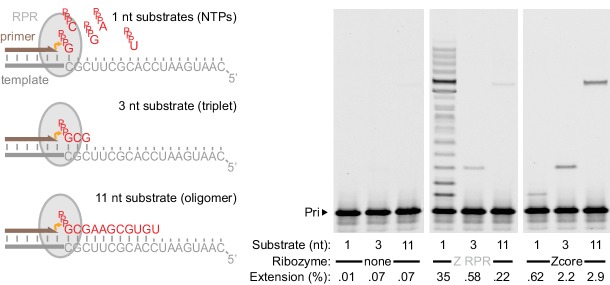
Templated ligase activity from a mononucleotide polymerase.Extension of primer A11 on template HTI by the Z RPR (Wochner et al., 2011) and a 3’ truncation of it (Zcore, Figure 1a) at −7˚C in ice for 8 days (0.5 μM of each RNA), adding as substrates either a long oligonucleotide (‘11 nt’, pppGCGAAGCGUGU at 0.5 μM), a triplet (‘3 nt’, pppGCG at 5 μM), or NTPs (‘1 nt’, at 1 mM each). Gel densitometry was used to calculate the percentage of primer extended (shown below each lane). Z RPR has only a very limited template ligation activity (slightly exceeding background nonenzymatic ligation [Rohatgi et al., 1996]). In contrast, 3’ truncation (which abolished mononucleotide polymerase activity) accommodated and enhanced templated ligation.